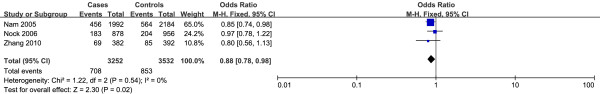
Forest plots for hOGG1 Ser326Cys polymorphism and risk of Prostate cancer in mixed population (Cys allele versus Ser allele). The squares and horizontal lines correspond to the study specific OR and 95% CI. The area of the squares reflects the weight (inverse of the variance). The diamond represents the summary OR and 95% CI.